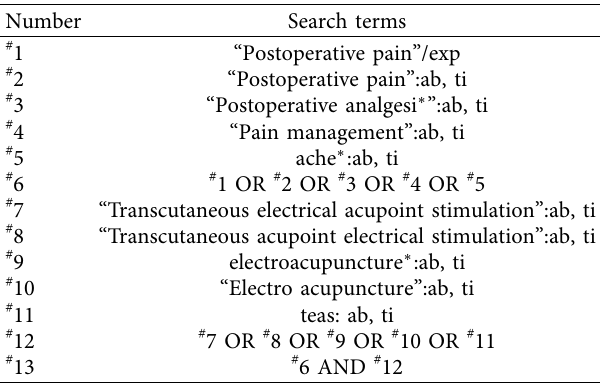
Table 1: Embase search